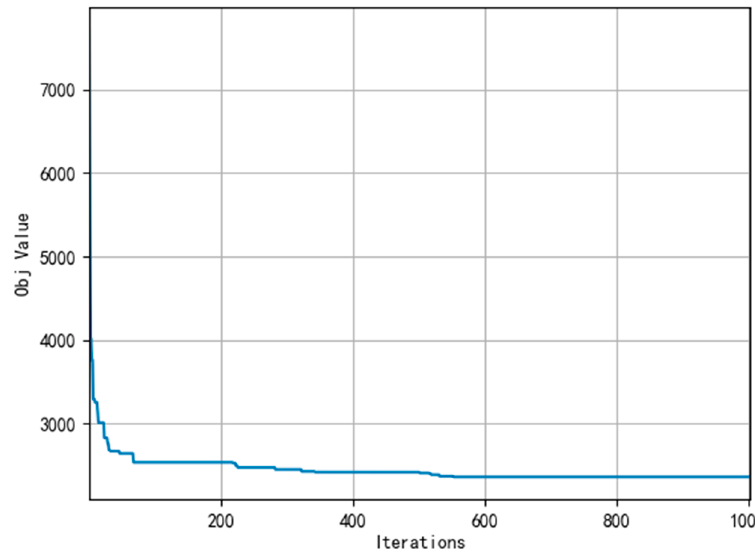
Figure 7. Convergence curve of AGA.